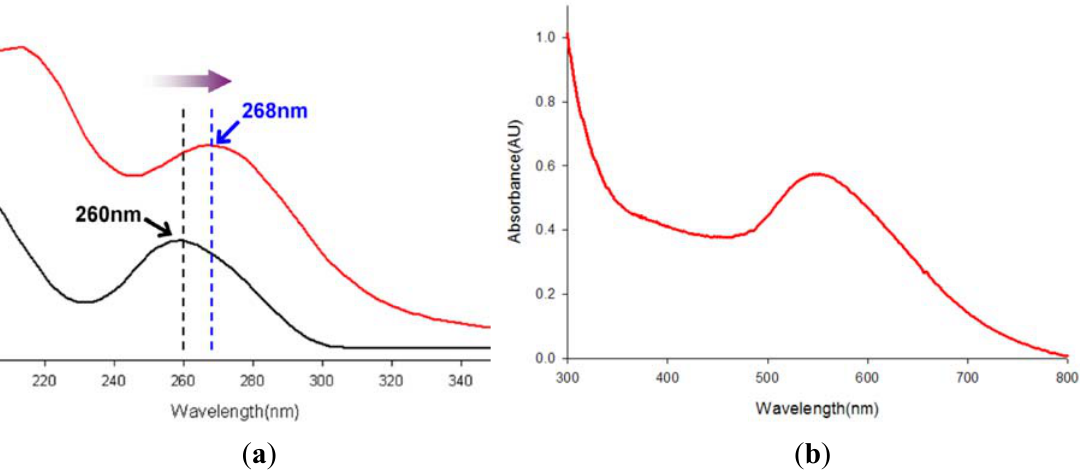
Figure 1. UV-visible spectra of ( a ) DNA (black color) and DNA-Au(III) complex (red color) and ( b ) DNA-mediated gold nanoparticle.